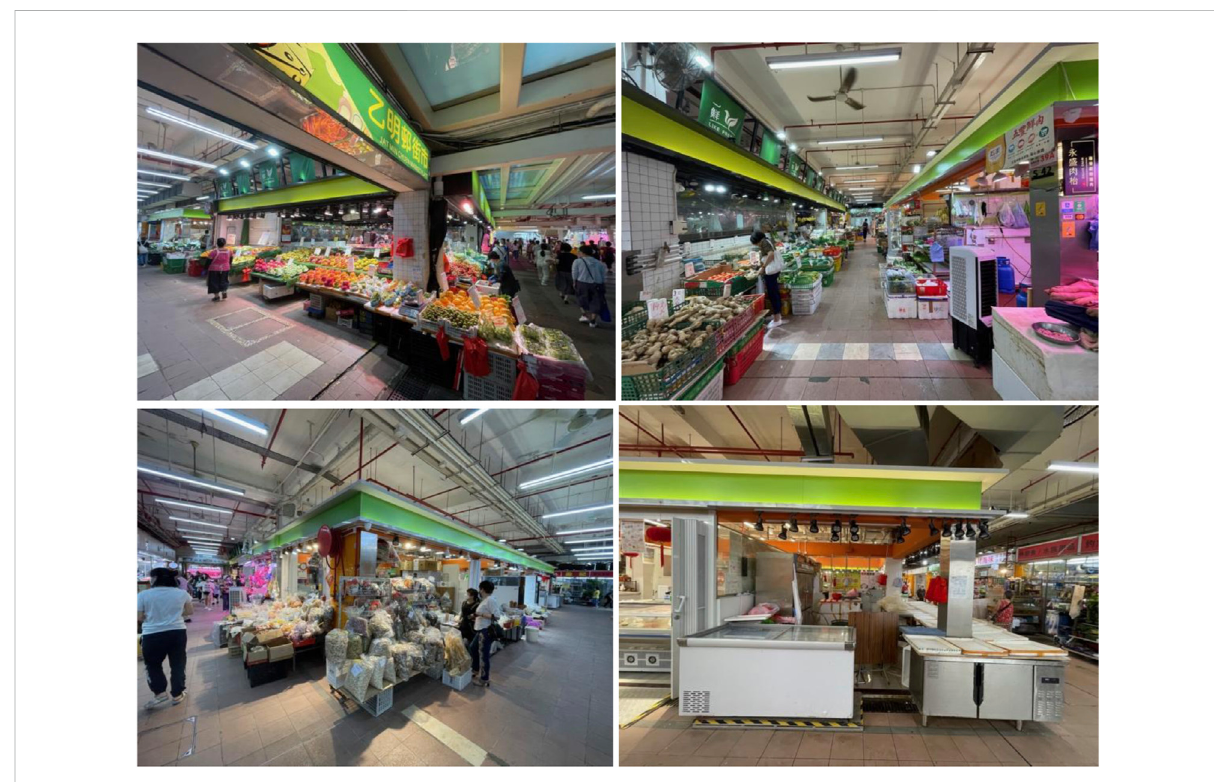
FIGURE 3 Photos of the wet market at JMC, with typical conditions such as an indoor and air-conditioned setting, and small store plots rented out to business